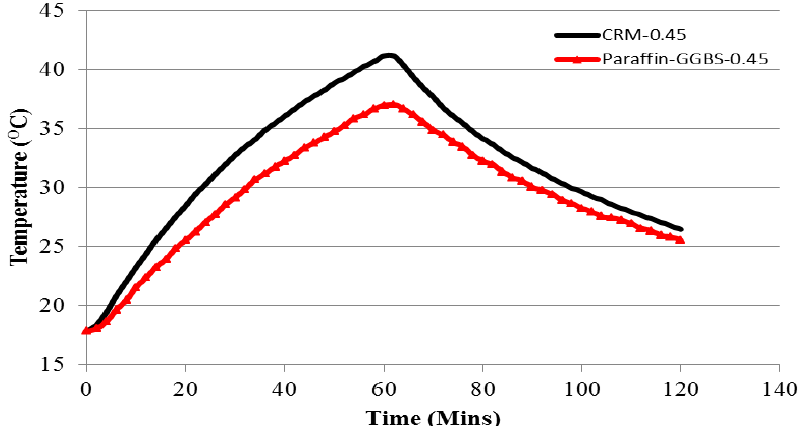
Figure 12. Indoor temperature variation at the center of the room model—Control and Paraffin-GGBS composite room